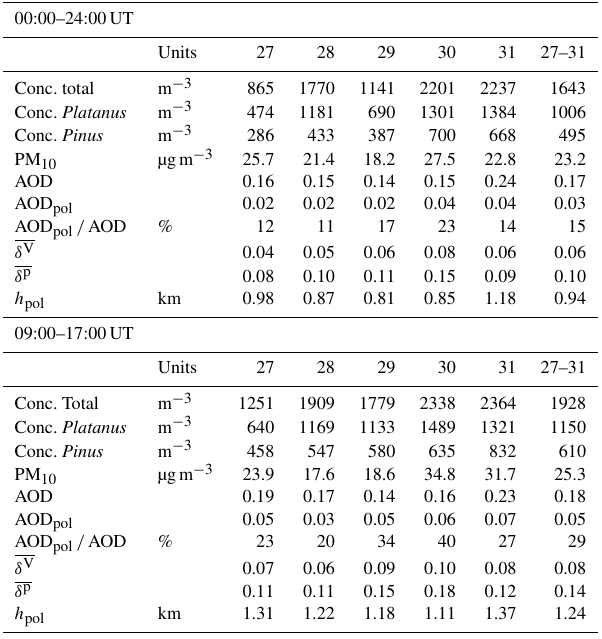
Table 1. Mean parameters during the pollination event calculated over the periods of 00:00–24:00 and